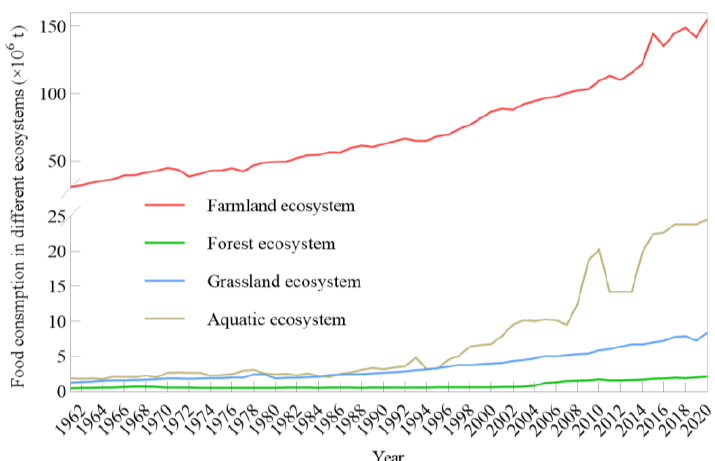
Figure 2. Food consumption in different ecosystems.